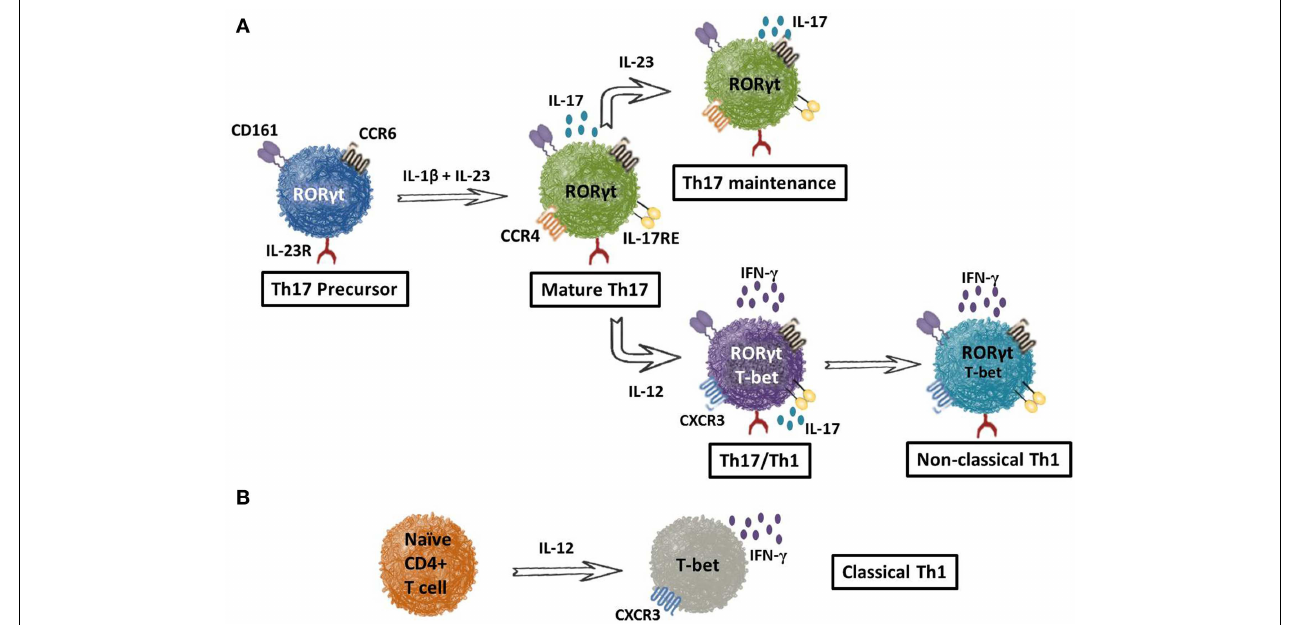
cells adopt a divergent phenotype that has bothTh1 andTh17-like aspects.These cells, termedTh1/Th17 cells, express CXCR3 instead of CCR4, produce both IFN- γ as well as IL-17A, and have a high expression of ROR γ t with an intermediate expression of theTh1 transcription factor,T-bet. In the continued presence of IL-12,Th1/Th17 cells can adopt aTh1-like phenotype and are termed non-classicalTh1 cells. As shown, non-classicalTh1 cells have an increased expression ofT-bet, decreased ROR γ t, and produce only IFN- γ . (B) ClassicalTh1 cells are directly derived from naïve CD4 + T cells in the presence of IL-12 and can be identified through the expression of CXCR3, IFN- γ ,